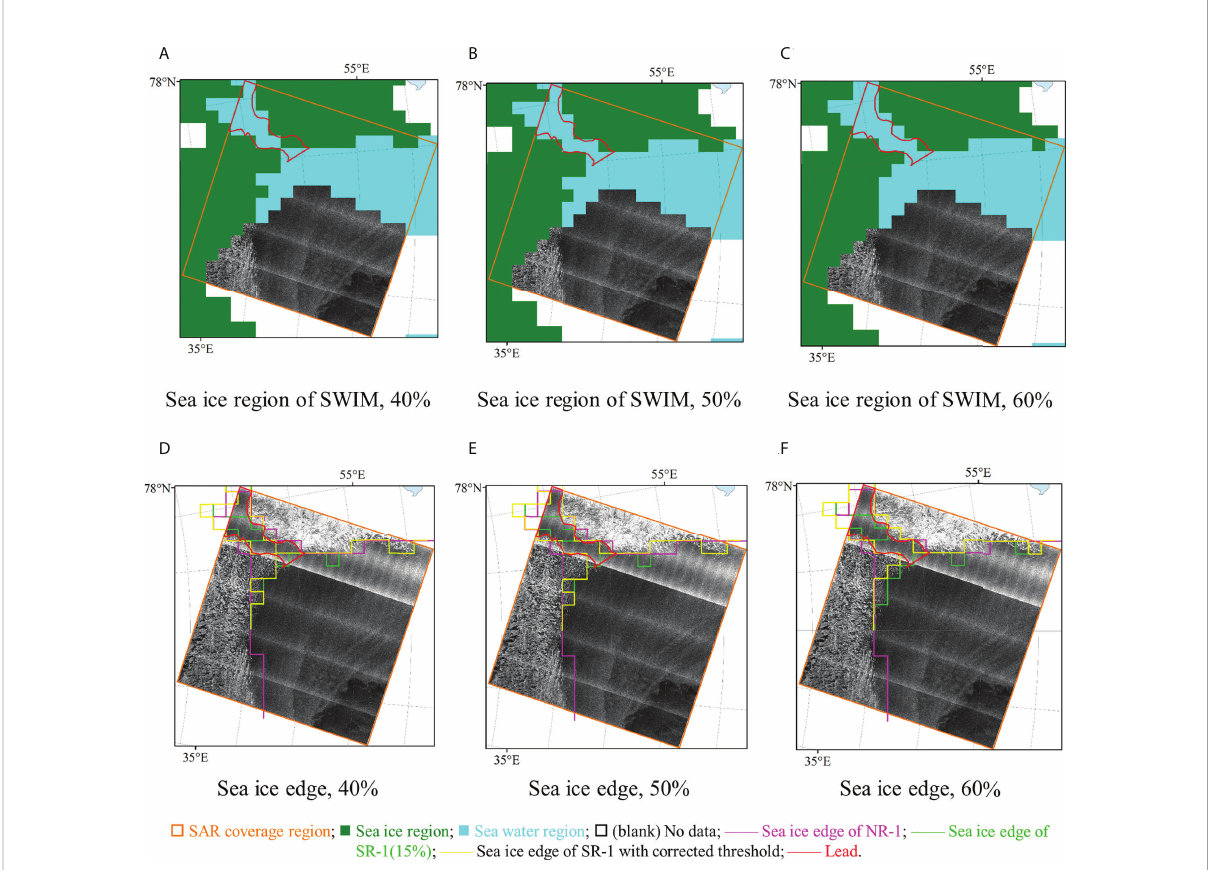
FIGURE 10 Sea ice edges based on SWIM data with different thresholds of the sea ice proportion. (A) Sea ice region of SWIM, 40%; (B) Sea ice region of SWIM, 50%; (C) Sea ice region of SWIM, 60%; (D) Sea ice edges, 40%; (E) Sea ice edges, 50%; (F) Sea ice edges,